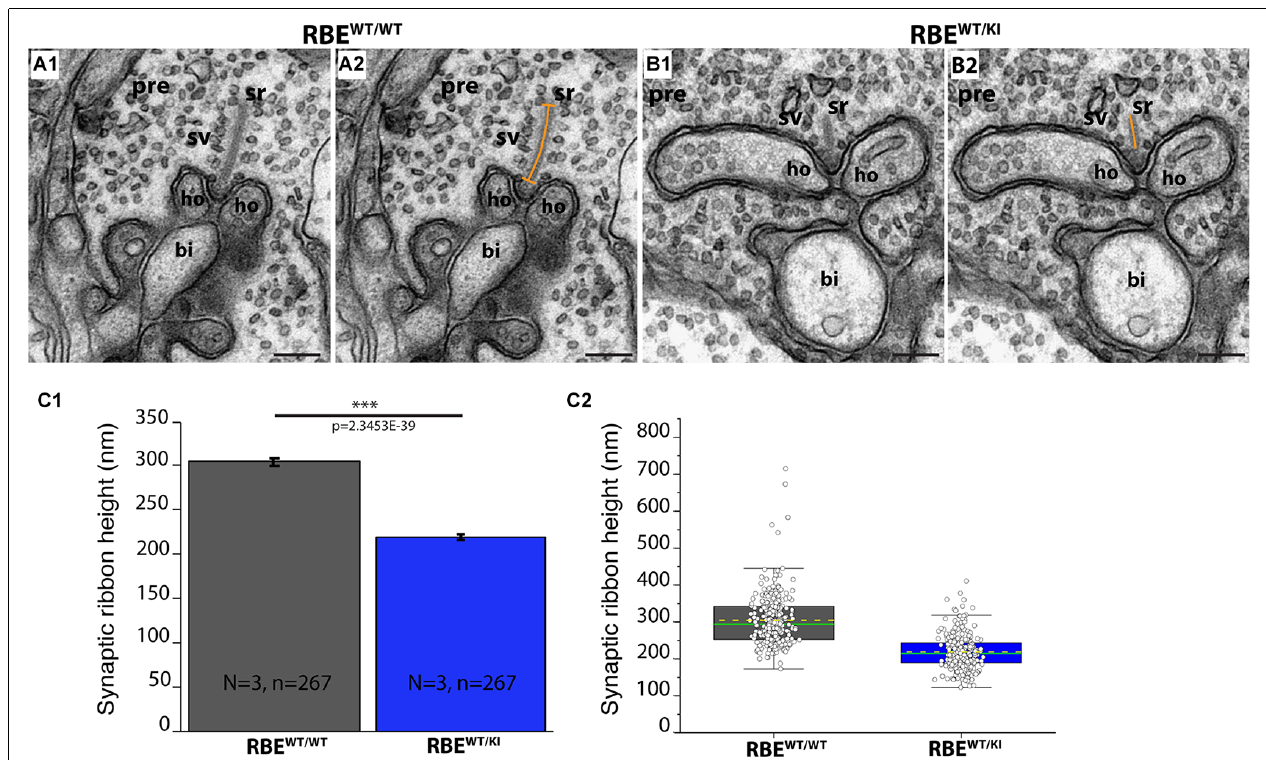
FIGURE 10 | The height of rod photoreceptor synaptic ribbon is shorter in RBE WT/KI mice in comparison to RBE WT/WT mice. (A,B) Representative transmission EM images of cross-sectioned synaptic ribbon from rod-photoreceptor synapses of RBE WT/WT mice (A1,A2) and RBE WT/KI mice (B1,B2) . The dashed orange line in (A2,B2) demonstrates how synaptic ribbon height was determined. (C) Quantitative analyses. Values in (C1) are means ± S.E.M.: 304.6 nm ± 4.3 nm ribbon height in RBE WT/WT mice; 219.1 nm ± 2.9 nm in RBE WT/KI mice. In the box and whisker plot (C2) of the data from (C1) , mean values are indicated by dotted horizontal lines; median values by solid horizontal lines. Boxes represent the 25th-75th percentiles of data points and whiskers are equal to 1.5 times of the interquartile range (IQR). Kolmogorov-Smirnov tests were used to determine the statistical significance. Abbreviations: sr, synaptic ribbon; ho, horizontal cells; sv, synaptic vesicles; pre, presynaptic; bi, bipolar cell; RBE, RIBEYE; S.E.M., standard error of the mean; N = number of mice, n = number of analyzed images; ∗∗∗ p ≤ 0.001. Scale bar: 200 nm.